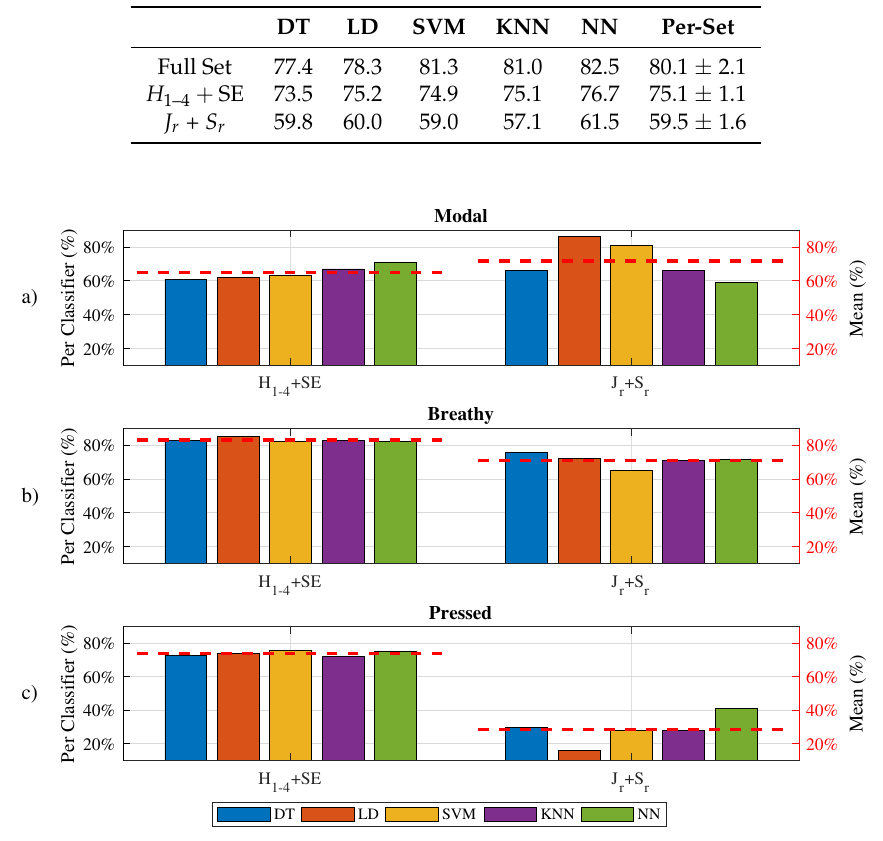
Figure 8. Per-type classification accuracies for the spectral set and the stability set. The red dashed line represents that averaged accuracy on a dataset using different